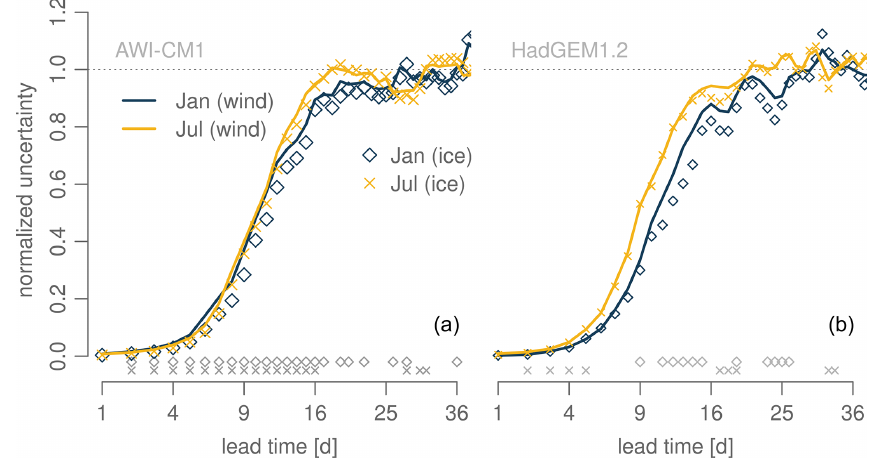
Figure 9. Normalized uncertainty in near-surface wind vectors in Eulerian perspective for AWI-CM1 (a) and HadGEM1.2 (b) . Solid (dashed) lines denote the mean for January (July) initializations, and the normalized uncertainty in Eulerian ice drift vectors is added for comparison as diamonds (crosses) for January (July). The horizontal gray dotted line marks the climatological saturation value of 1. The diamonds and crosses above the horizontal axis denote those lead times for which the uncertainty for the ice velocity vectors is significantly lower than the uncertainty for wind vectors (one-sided paired t test, 0 . 95